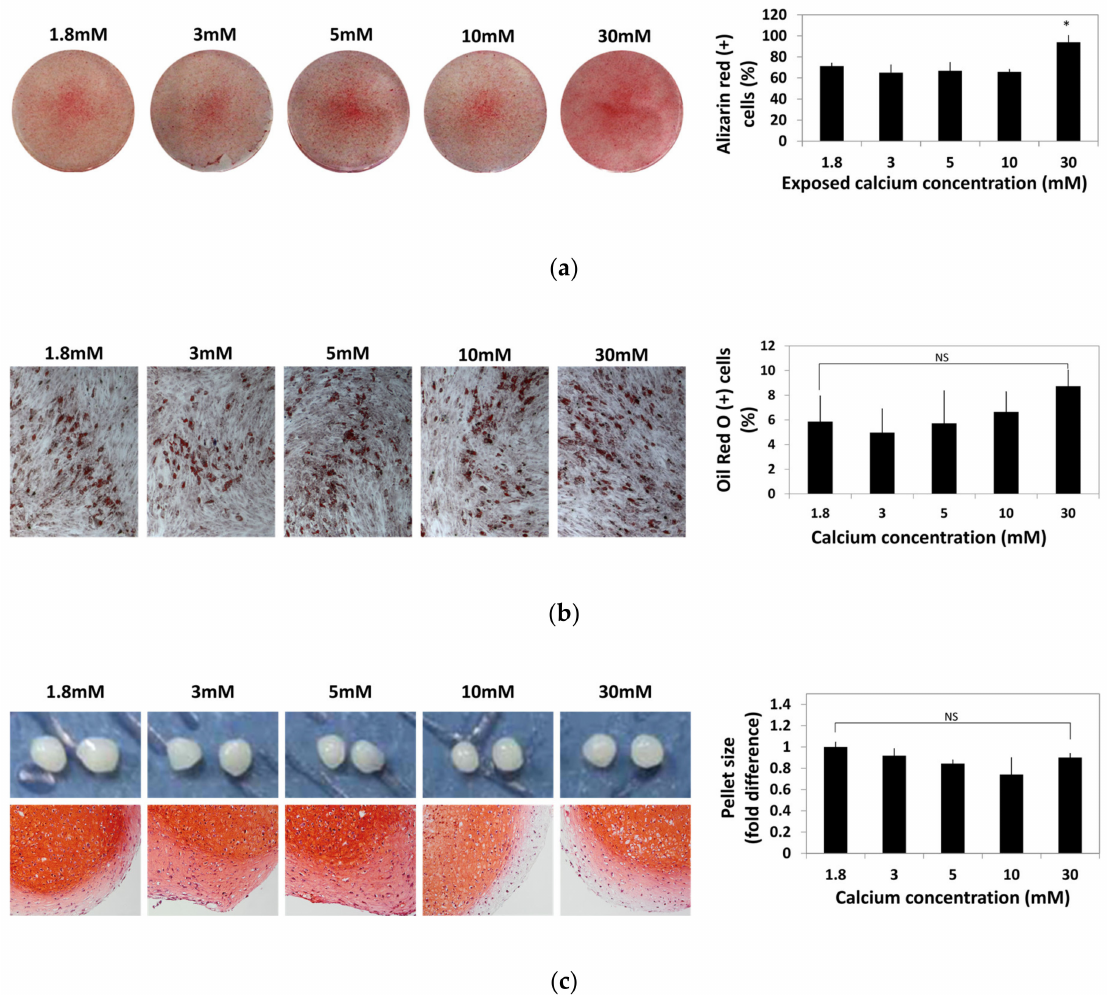
Figure 4. Effect of various calcium concentrations on multi-lineage differentiation potentials of hBMSCs. hBMSCs were treated with various calcium concentrations for 48 h and cultured in differentiation induction media for four weeks. ( a ) Calcium depositions in hBMSCs subjected to osteogenesis were visualized by Alizarin Red S staining. The intensity of Alizarin Red S staining was evaluated by ImageJ software (* p = 0.0113). ( b ) hBMSCs subjected to adipogenesis was stained by Oil Red O. The extent of adipogenesis was determined by comparing the proportion of Oil Red O-positive cells normalized by the number of total nuclei. ( c ) After in vitro chondrogenesis, the cartilaginous matrix formation was confirmed by Safranin O